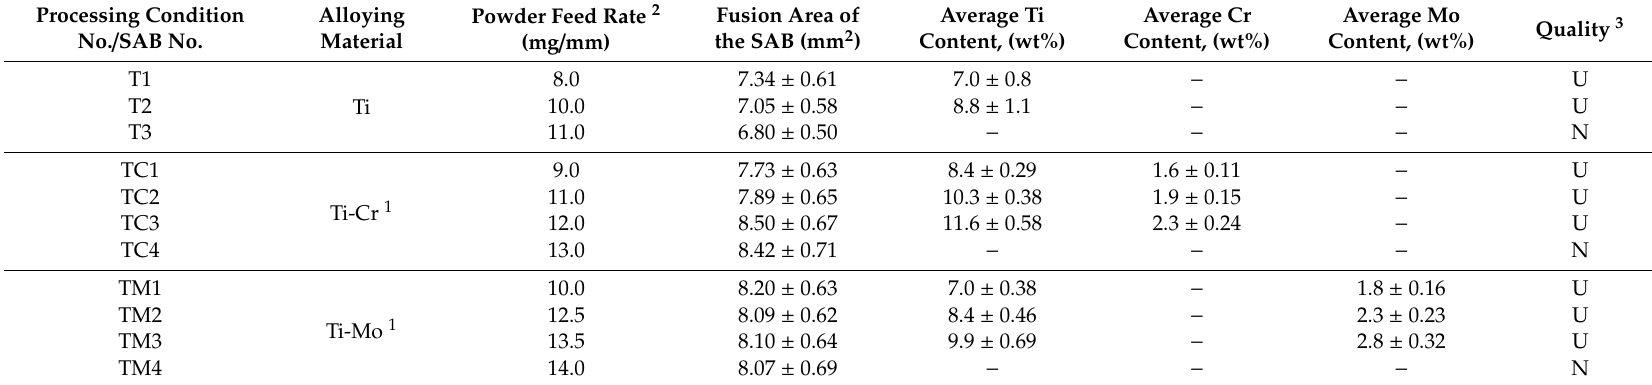
Table 2. E ff ect of the chemical composition of the alloying material and powder feed rate on the fusion area of the single-alloyed beads (SAB) and the concentration of alloying elements in the